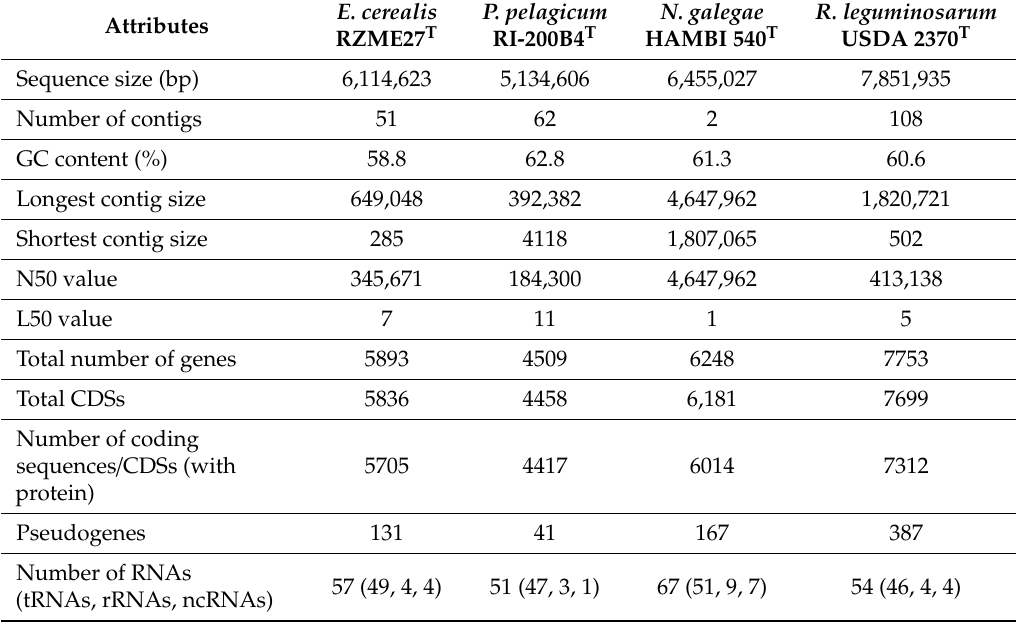
Figure 2. Genome circular representation and subsystems category distribution of annotated genes of the Endobacterium cerealis RZME27 T genome. ( A ) From the outer circle to the inner circle, the genomic map of RZME27 T shows: contigs (light grey), open reading frames (ORFs; dark green), GC skew curves ( +/ − ; green / purple), GC content (black), Start / Stop codons (dark blue / red), coding sequences (CDSs; blue), tRNAs (light green), rRNAs (violet) and tmRNAs (light blue). ( B ) Annotation of RZME27 T genome via the RAST server. The panel shows the annotation coverage, the categories distribution and the feature counts. Table 1. Genome properties of the Endobacterium cerealis , its closest related genera and the type species of the type genus of family Rhizobiaceae